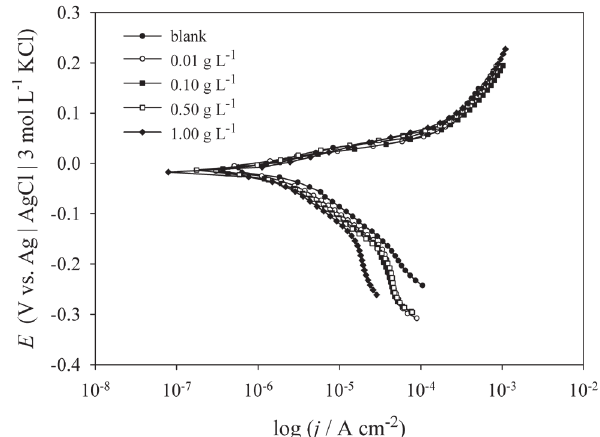
Fig. 1 – Potentiodynamic polarisation curves for the Cu elec­ trode in simulated acid rain solution, pH 4.5, containing different concentrations of HI extract (shown in figure); ν = 1 mV s